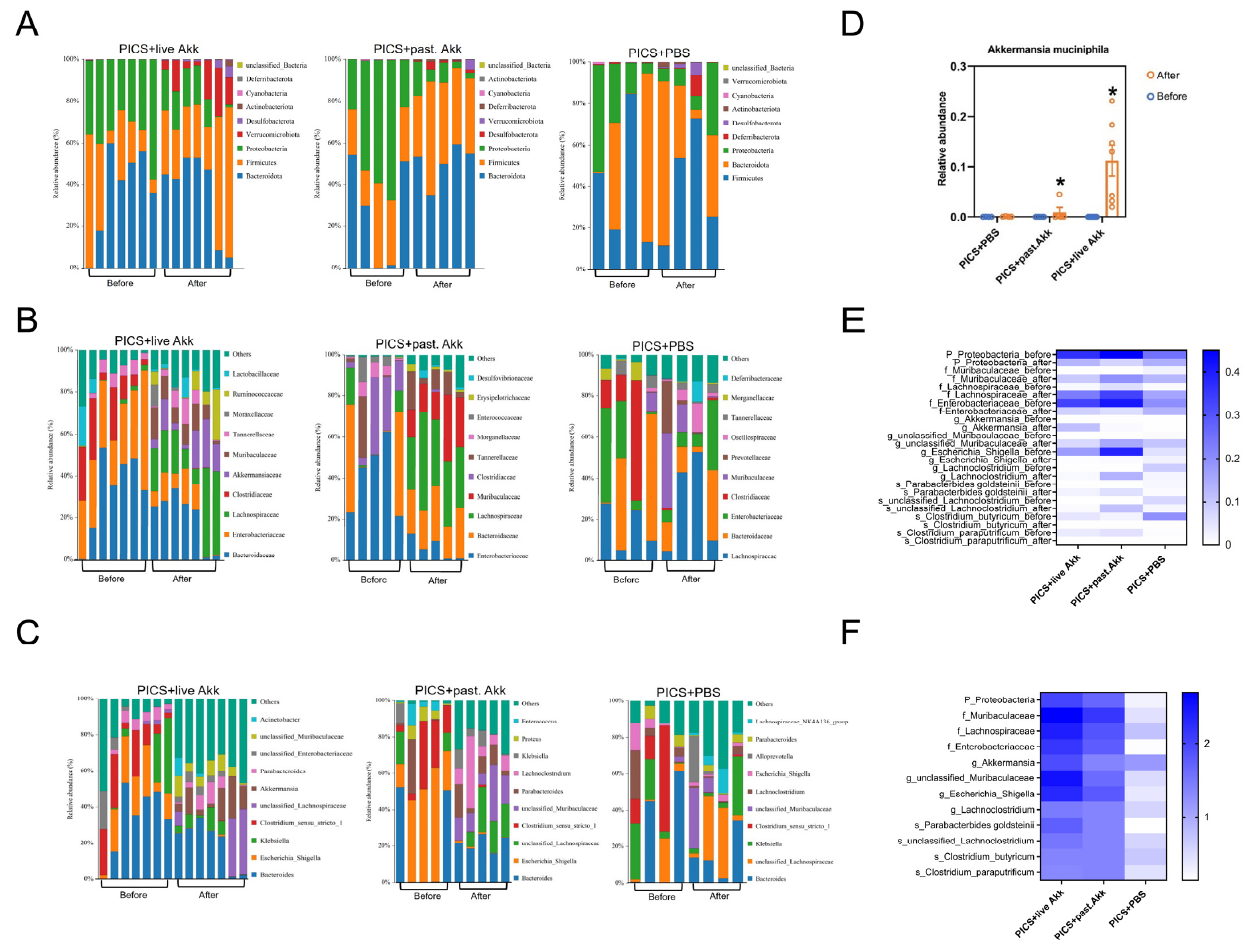
Figure 4. Pasteurized and live Akk reshapes the gut microbiota community. ( A – C ) Bar chart of fecal bacterial community composition at the phylum ( A ), family ( B ) and genus ( C ) levels at day 14. ( D ) Relative abundance of Akk at the genus level before and after treatment at day 14. ( E ) Heatmap of the statistically different intestinal microbiota after pasteurized and live Akk treatment and PBS in PICS mice at day 14. ( F ) A heatmap generated by the -log( p -value) was drawn to show the alterative levels of the microbial community in Figure 4E. past. = pasteurized. Data are shown as the mean ± SEM. * p < 0.05, ** p < 0.01, in comparison with the same group before treatment.